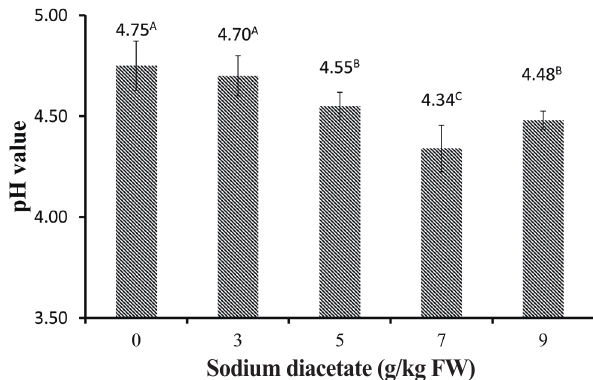
Figure 1. The pH value of alfalfa silages treated with 0, 3, 5, 7, and 9 g/kg FW sodium diacetate ensiled for 60 days. Vertical bars are the standard errors of the means, bars with unlike letters differ (p<0.05, n = 5). FW, fresh weight.